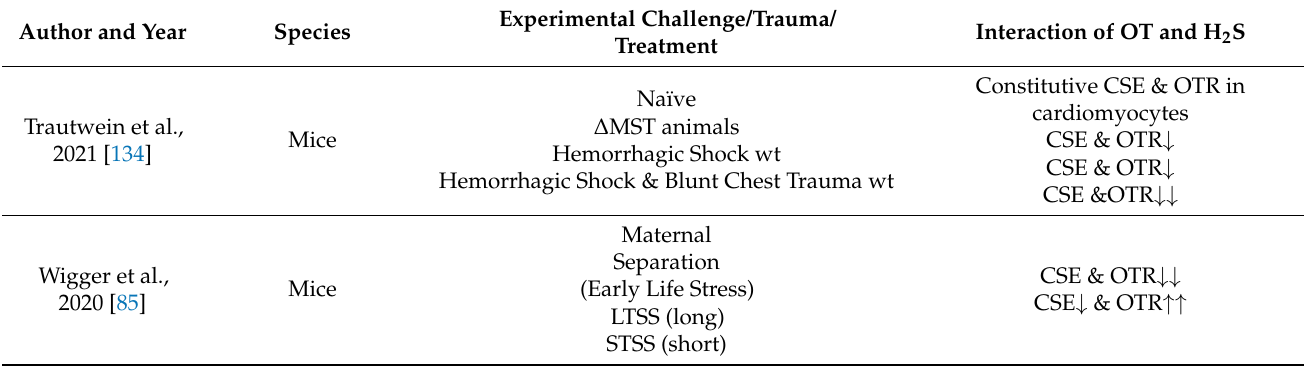
Table 1. Summary of studies: Interaction of the H 2 S system and the OT/OTR